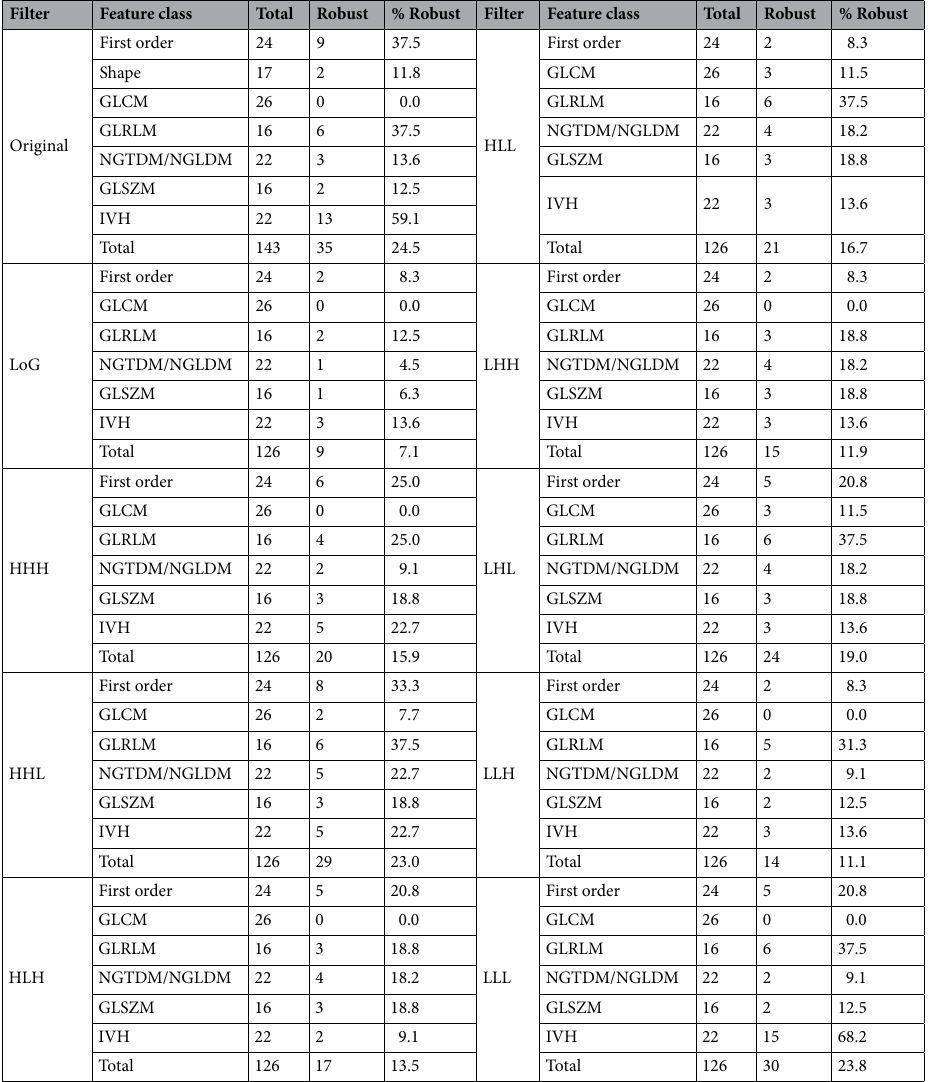
Table 2. Statistic summary table of radiologist derived stable features. Total count of first order, shape, gray-level co-occurrence matrix (GLCM), gray-level run length matrix (GLRLM), neighboring gray tone difference matrix (NGTDM), and neighboring gray-level dependence matrix (NGLDM), gray-level size zone matrix (GLSZM), and IVH features with respective robust features counts are listed. Feature definitions